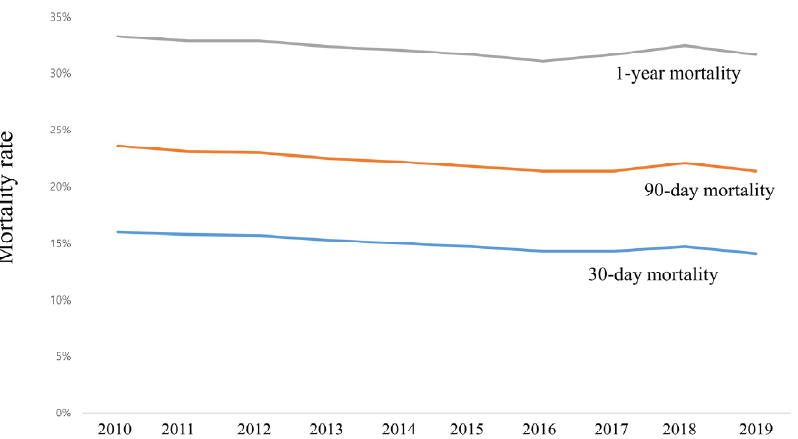
Figure 2. Trends of mortality after ICU admission among patients admitted to the ICU from 2010 to 2019. ICU, intensive care unit.